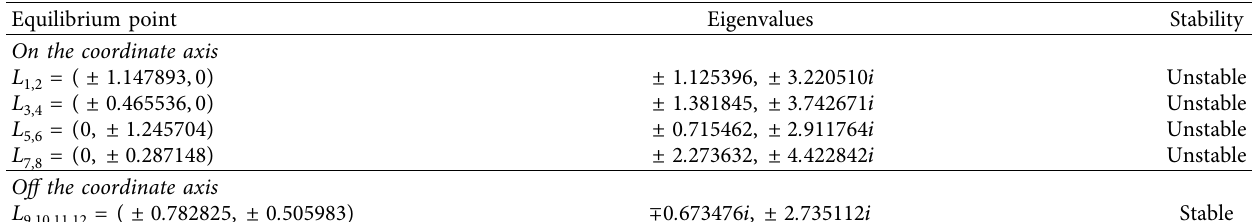
Table 3: Equilibrium points, eigenvalues, and stability status when b � 0 . 67 and a � 0 . 78 .